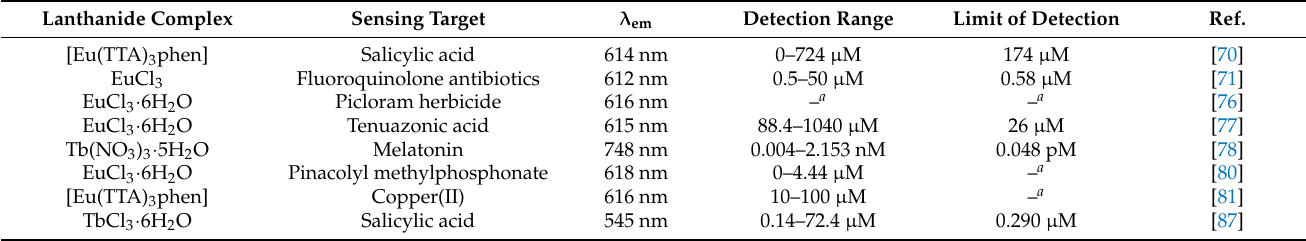
Table 2. Selected examples of Lanthanide-based luminescent MIP